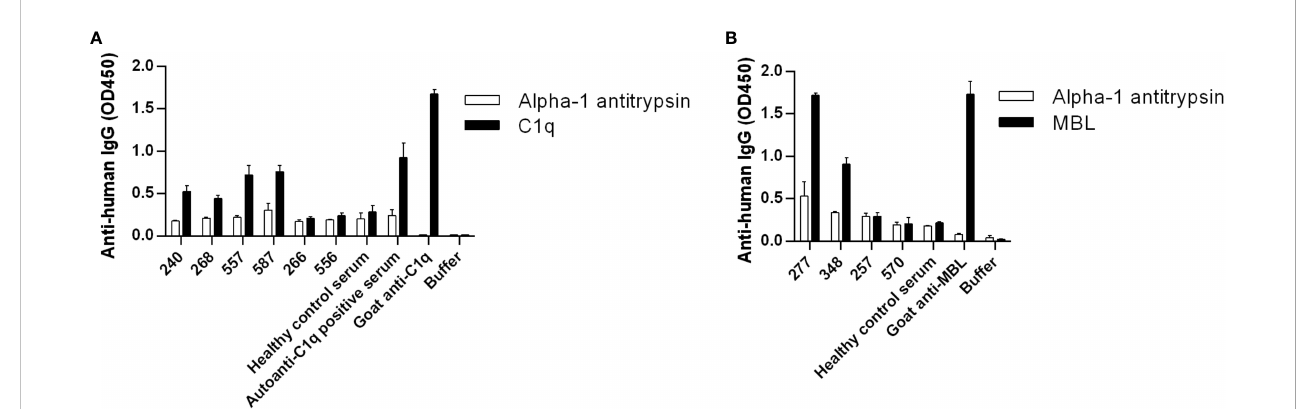
FIGURE 1 Detection of autoantibodies against C1q and MBL in RA patients. (A) C1q, (B) MBL, and alpha-1 antitrypsin as negative control were immobilized on microtiter plate wells. After blocking, serum samples diluted 1:50 were added. In the case of C1q, high salt concentration buffer was used and in the case of MBL 10 mM EDTA was used to exclude unspeci fi c binding, as described in Materials and methods. Bound IgG was detected by HRP-conjugated anti-human IgG. Selected samples are shown: positive patient samples, some negative patient samples and controls. For full datasets please refer to Supplementary Figure 1. Data are mean ± SEM of two